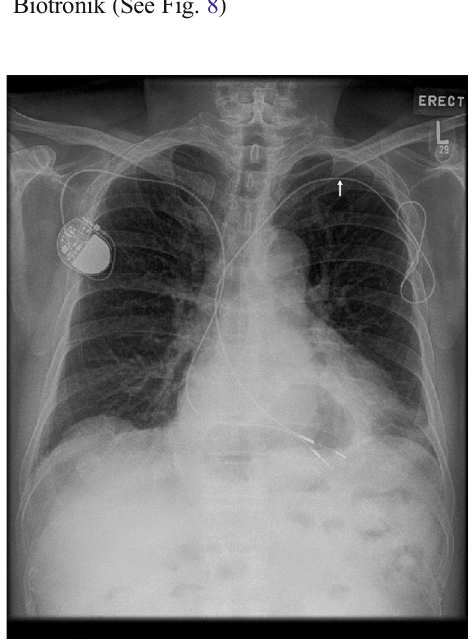
Fig. 15 A single-lead right-sided pacemaker is present. There is also an abandoned left-sided lead without the pulse generator unit, indicated by an arrow.